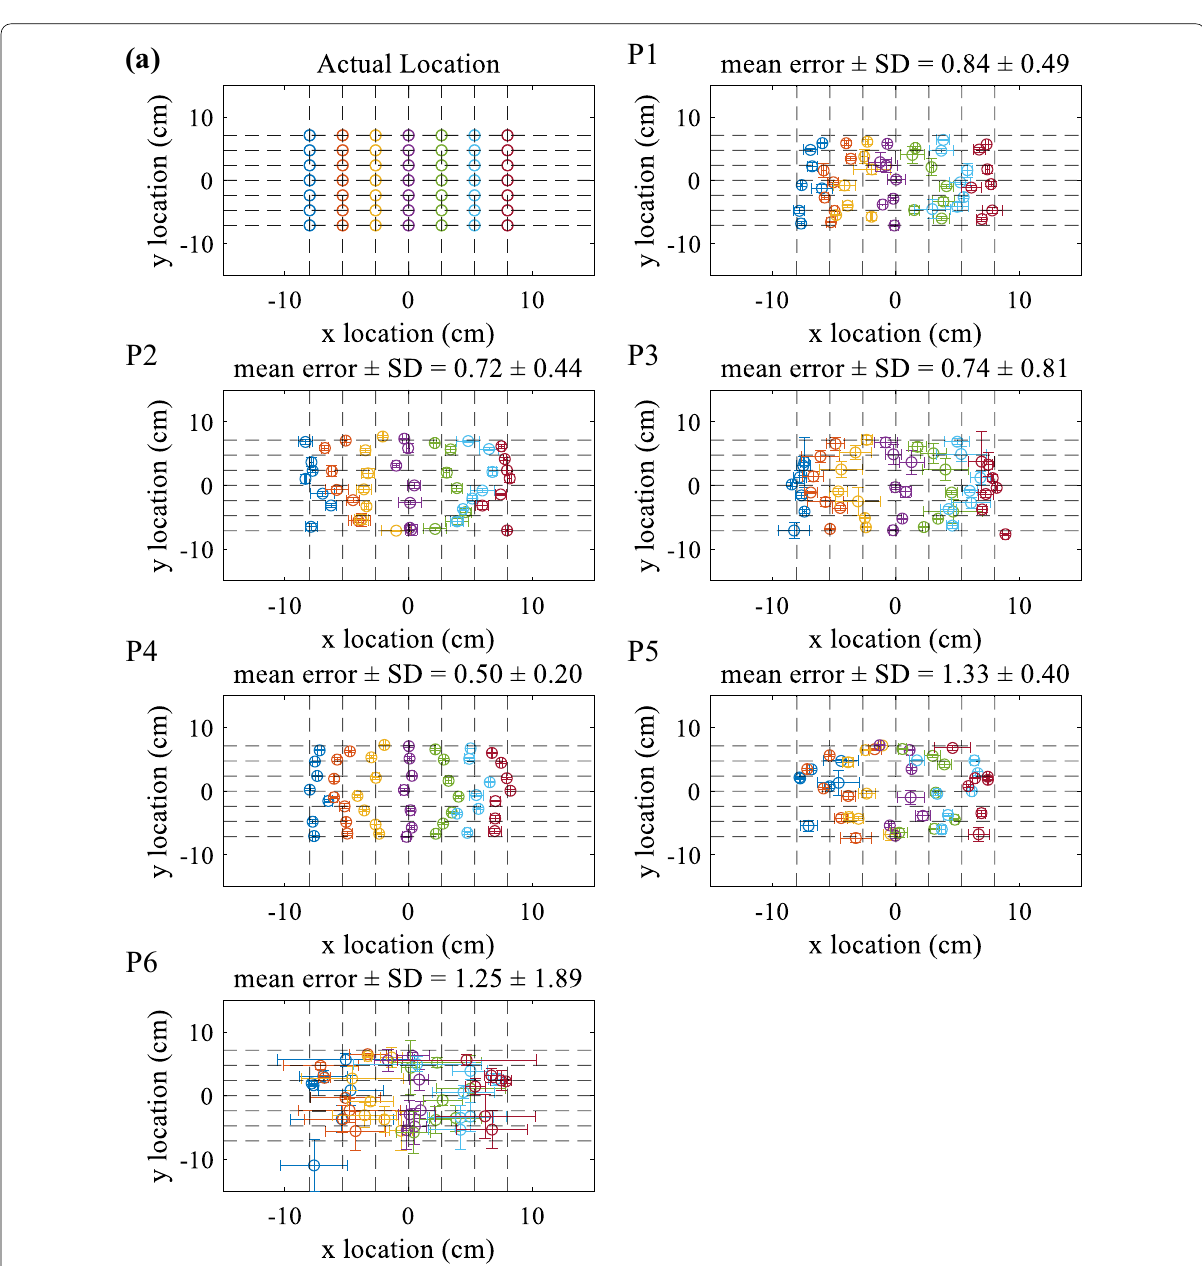
Fig. 6 Results of the semipersonalized model using point 44 with w = 1000 . a Actual locations of the 49 marked points. (P1–P6) Mean estimated location and standard deviation of each of the six participants,